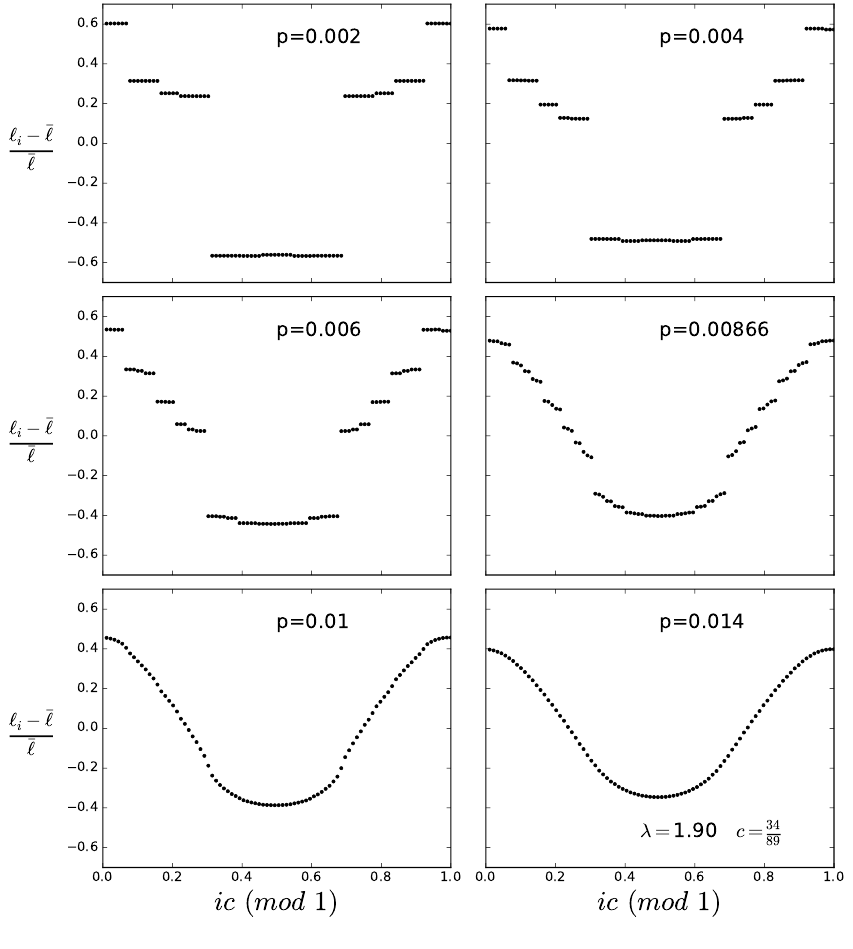
Figure 17: Envelope functions for the c = 34 approximant of the incommensurate 89 case, for different pressures p , showing an Aubry transition from a continuous to a discontinuous envelope function. Here λ = 1.90, ξ =